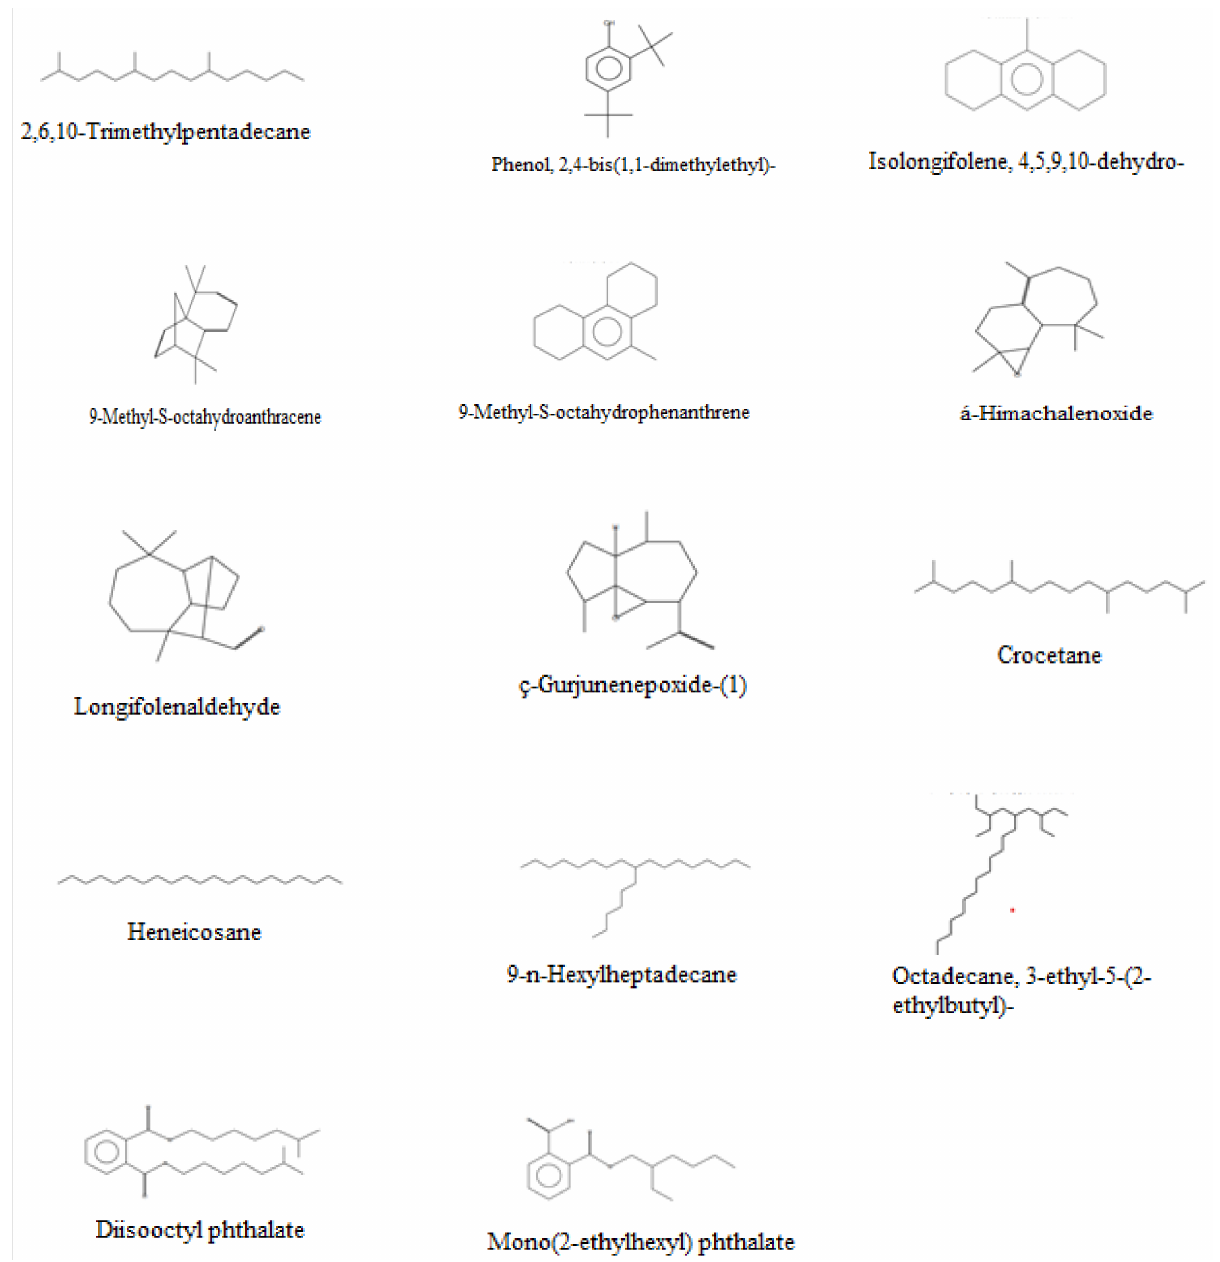
Figure 5. Chemical structures of the major phytochemical compounds identified in Indigofera linifolia crude